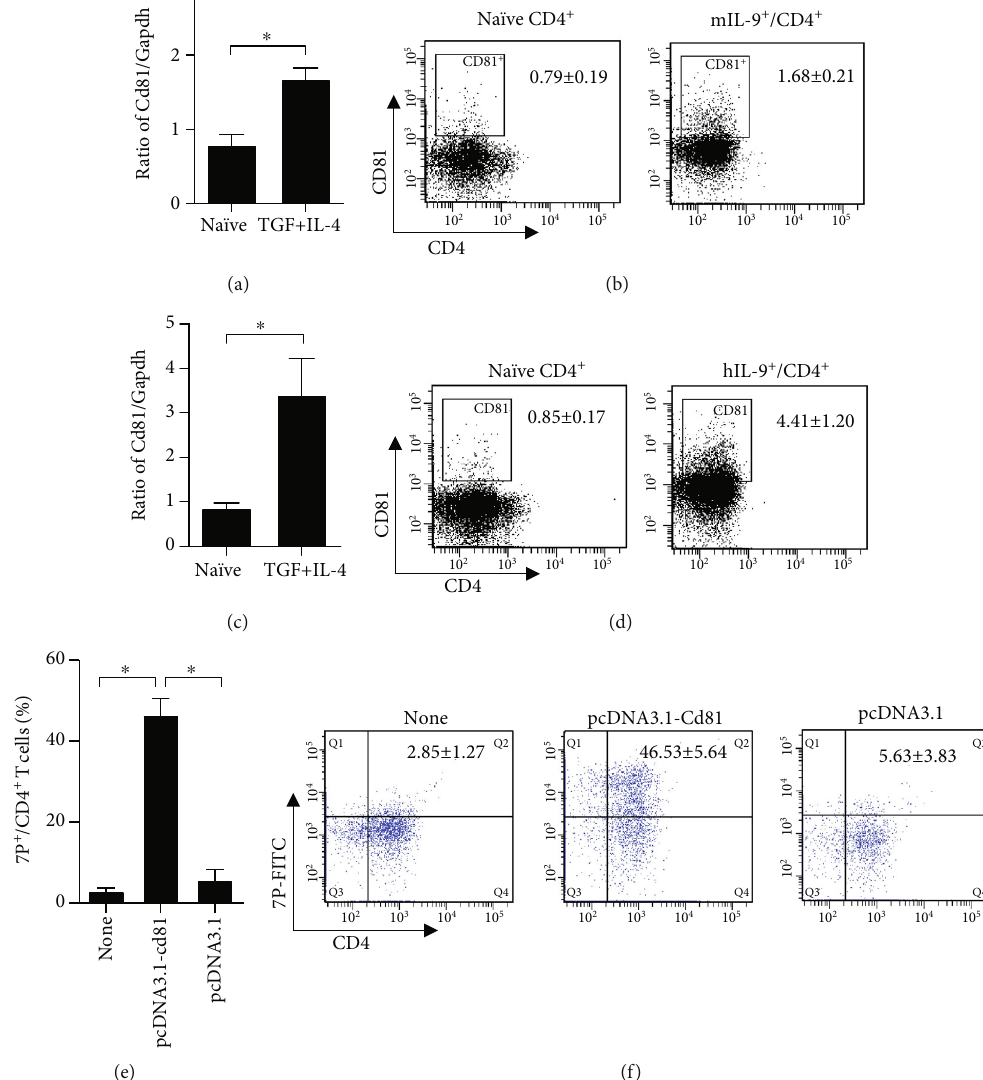
Figure 4: CD81 expression during mouse and human Th9 cell di ff erentiation. Naïve CD4 + T cells and 7P bind to CD81. (a – d) Mouse and human naïve CD4 + T cells isolated from mouse spleen and human peripheral blood were stimulated with anti-CD3 (3 μ g/mL), anti-CD28 (3 μ g/mL), and anti-INF- γ (3 μ g/mL) with TGF- β (10 ng/mL) and IL-4 (10 or 20ng/mL) for 5 days to induce (a) mouse and (c) human Th9 cell di ff erentiation. Cells were analyzed for CD81 expression by qPCR ( n = 6 , ∗ p < 0 : 05 ). (b) Mouse and (d) human CD81 were examined by fl ow cytometry. (e, f) Naïve CD4 + T cells transfected with pcDNA3.1-CD81 and puri fi ed by FACS. Cells were stimulated with anti-CD3, anti-CD28, anti – INF- γ , TGF- β , and IL-4 (10 and 20 ng/mL) for 5 days, then stimulated for 4 h with 12-O- tetradecanoylphorbol-13-acetate and ionomycin (500ng/mL each) in the presence of brefeldin A (1 μ g/mL). Intracellular staining was performed with anti-CD4, IL-9, and CD81. CD81 expression was analyzed by fl ow cytometry with 7P-FITC in the gated CD4 + IL-9 + cell population. The percentage of 7P-positive Th9 cells was examined by FACS. Results were representative of three independent experiments ( n = 3 , ∗ p < 0 : 05